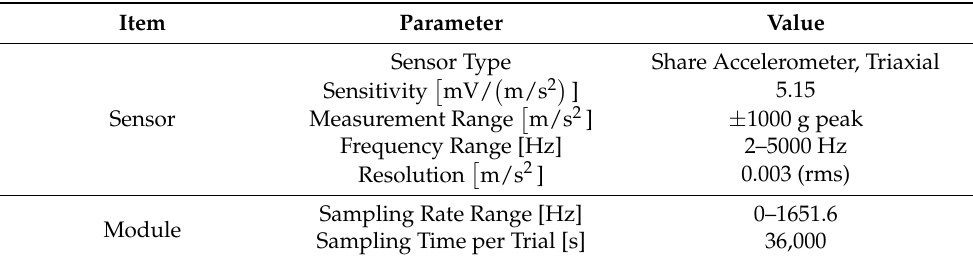
Figure 4. Possible main faults during gravure printing process: ( a ) Doctor blade tilting fault; ( b ) Printing roll eccentricity fault; ( c ) Nip roll eccentricity fault; and ( d ) Nip force non-uniformity fault .